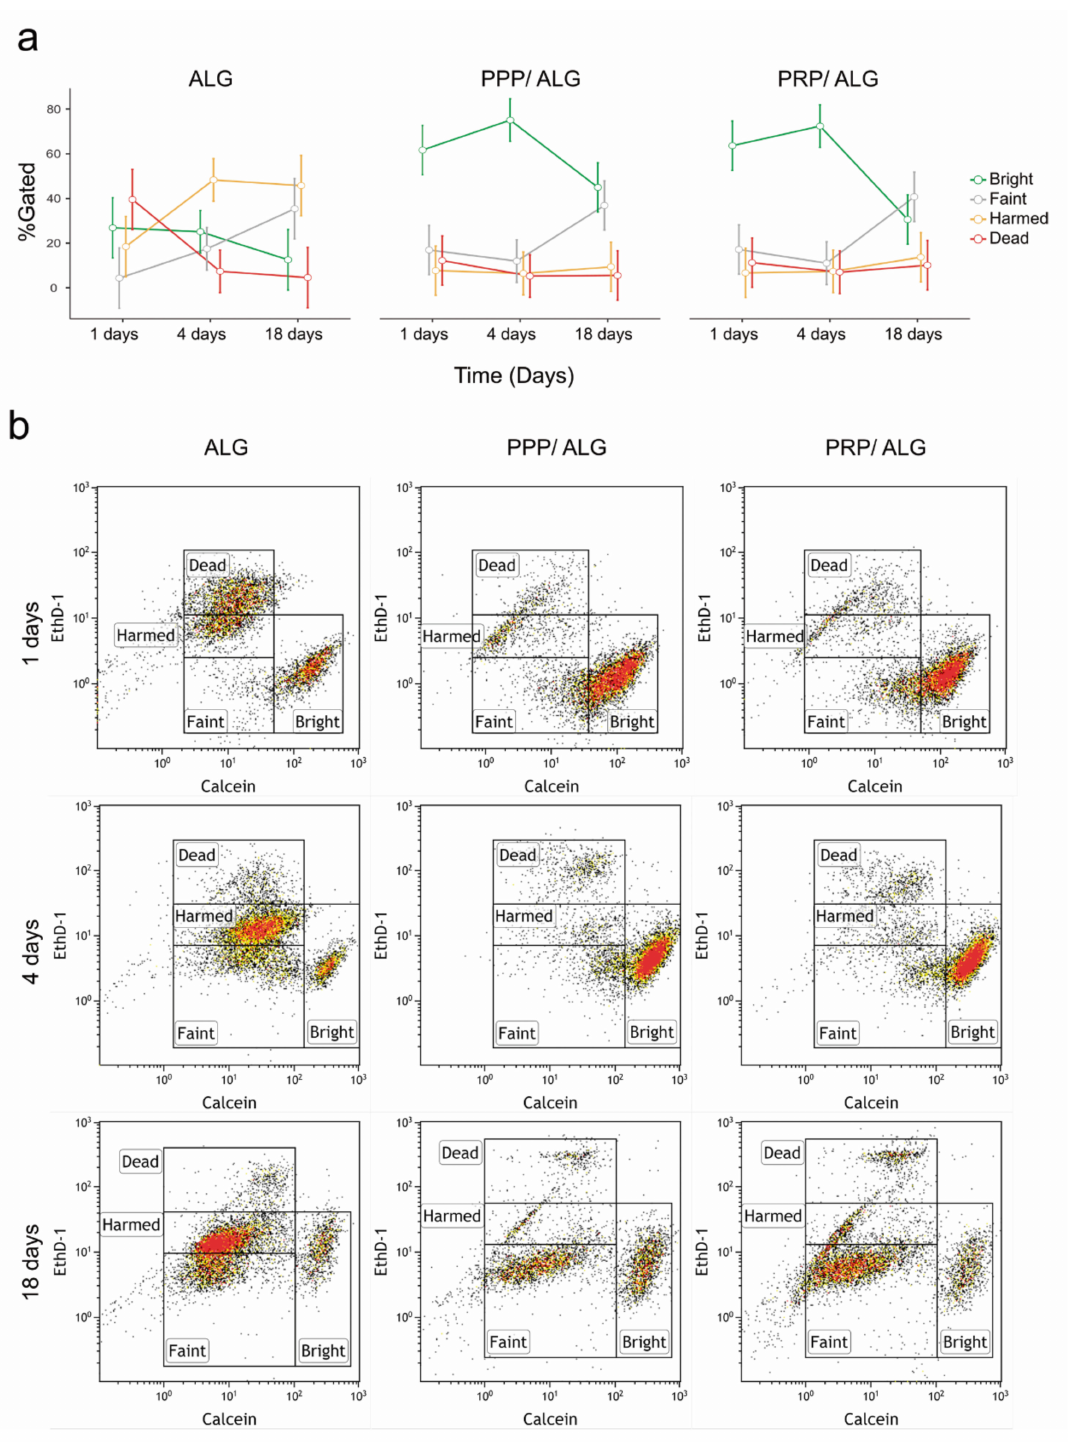
Figure 5. Live/dead flow cytometry analysis of diluted ALG, PPP/ALG, and PRP/ALG dressings on days 1, 4, and 18 after bioprinting. ( a ) Four cell populations were observed based on calcein and eth-D1 fluorescence signals: dead, injured, bright (alive with high metabolic activity), and faint (alive with low metabolic activity). ( b ) Flow cytometry density plots corresponding to 1, 4, and 18 days after bioprinting and showing the dead, injured, bright, and faint cell populations. ALG, alginate; PPP, platelet-poor plasma; PRP, platelet-rich plasma; etdh-1, ethidium